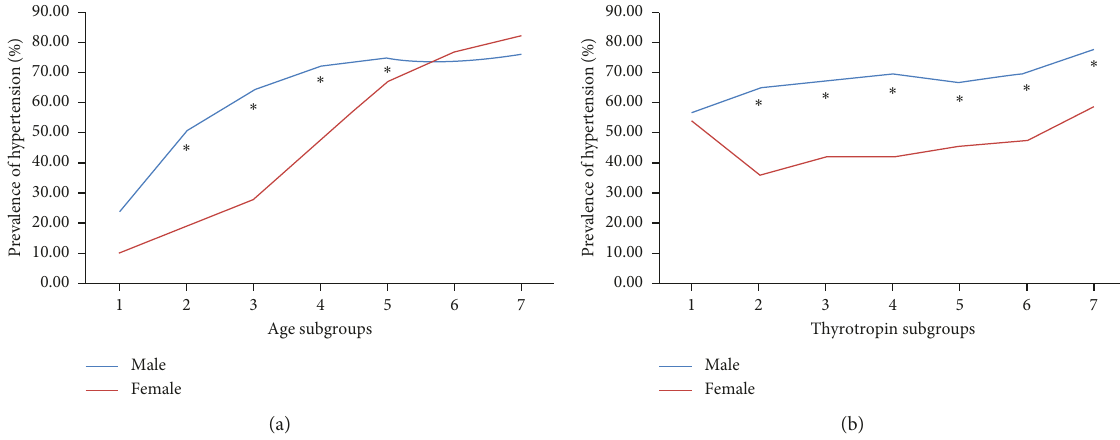
Figure 1: Prevalence of hypertension in different age subgroups or different thyrotropin subgroups. (a) Age subgroups 1 to 7 are referred as follows: age < 25 years, 25 years ≤ age < 35 years, 35 years ≤ age < 45 years, 45 years ≤ age < 55 years, 55 years ≤ age < 65 years, 65 years < age ≤ 75 years, and age > 75 years. ∗ Difference of prevalence between gender was significant at 0.01. (b) Thyrotropin subgroups 1 to 7 are referred as follows: TSH ≤ 0.3mIU/L, 0.3 μ lU/mL < TSH ≤ 1.0 μ lU/mL, 1.0 μ lU/mL < TSH ≤ 2.0 μ lU/mL, 2.0 μ lU/mL < TSH ≤ 3.0 μ lU/ mL, 3.0 μ lU/mL < TSH ≤ 4.0 μ lU/mL, 4.0 μ lU/mL < TSH ≤ 5.0 μ lU/mL, TSH > 5.0mIU/L. ∗ Difference of prevalence between gender was significant at 0.01.